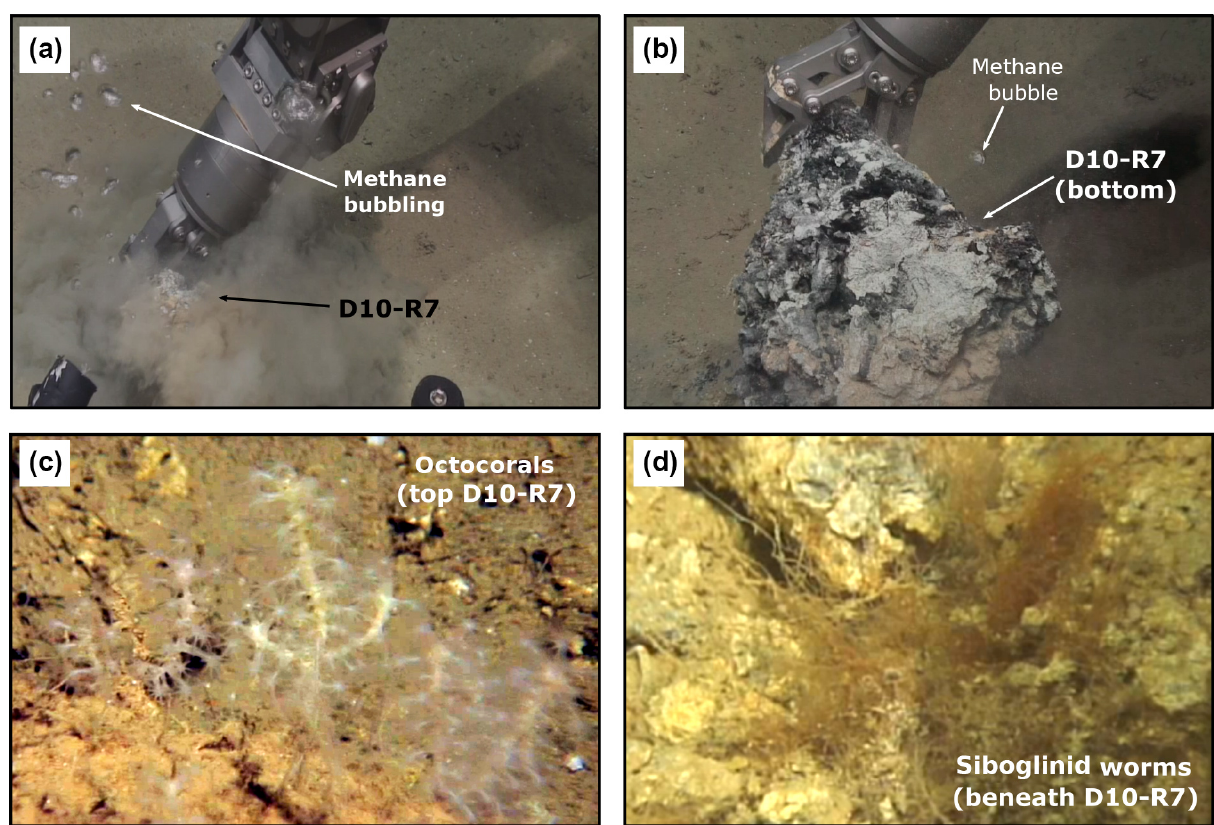
Figure 5. ROV still frames from the active pockmark site shown in Fig. 4b. (a–b) Release of bubbles while sampling. (c) Detailed photograph of the octocorals on top of the carbonate. (d) Detailed still frame from siboglinid worms beneath the carbonate. Table 3. On-site measurements of soluble Fe 2 + and S 2 + values from seawater and porewater. Please note that samples D10-C5, D10-C8 and D10-N4 were taken from the same site as the authigenic carbonate D10-R7 (see Fig. 2). Sample